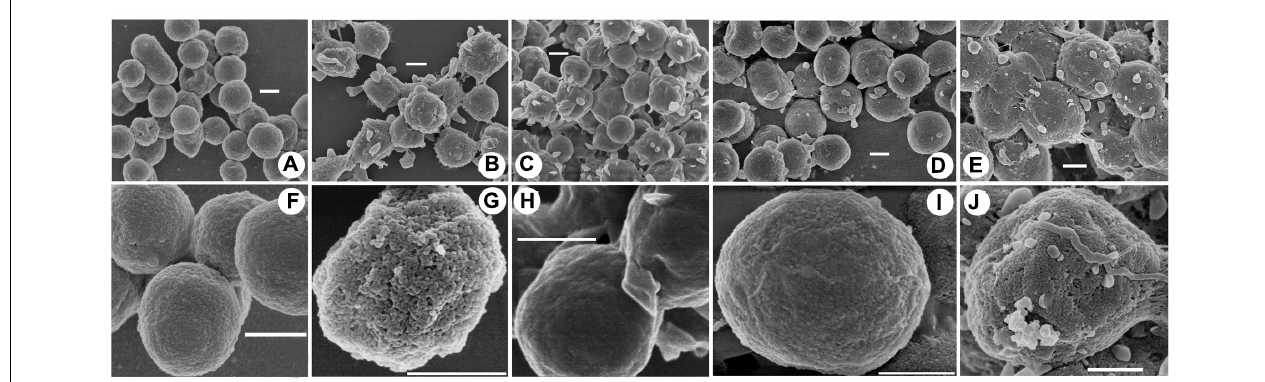
FIGURE 2 | Cell surface uncovered by scanning electron microscopy. Cells of strains were harvested in the late exponential phase by centrifugation. The cell surface ultrastructure of the cells of strains DF50 (A,F) , DF50- (cid:49) EPS (B,G) , DF50- (cid:49) EPS (cid:49) halH4 (C,H) , DF50- (cid:49) EPS (cid:49) halH4::H4 (D,I) , and DF50- (cid:49) EPS (cid:49) halH4 treated with original halocin-containing supernatants produced by strain Haloferax sp. Q22 (E,J) were determined by scanning electron microscopy (HITACHI SU8010, Japan). Bar, 500 nm.